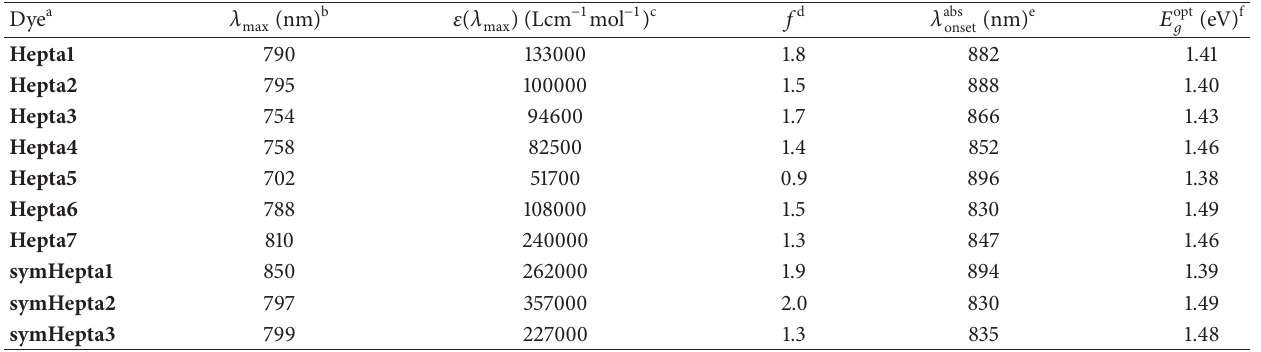
Table 1: Optical properties of the unsymmetrical and symmetrical heptamethine dyes in ethanol. Dye a